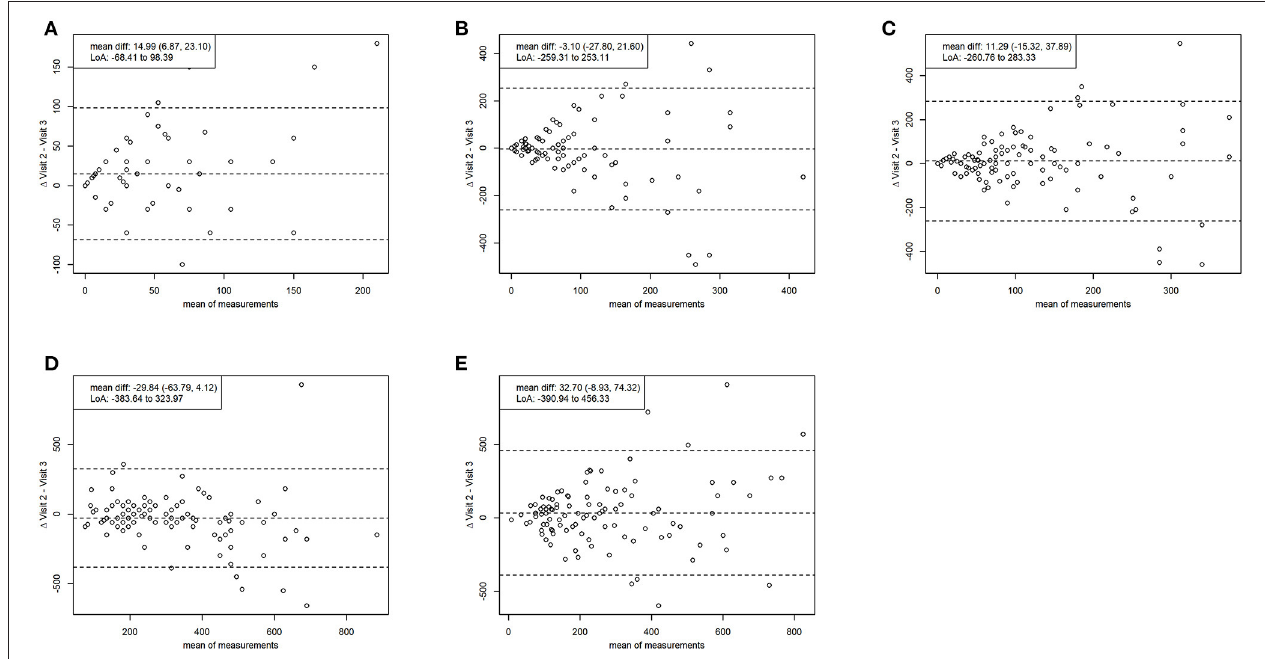
FIGURE 2 | Bland-altman plots reliability. Comparing average minutes intensive per day (A) , average minutes moderate per day (B) , average minutes moderate to vigorous per day (C) , average minutes sitting per day (D) , average minutes total physical activity (E) between the two measurement time points. Mean diff., mean difference with 95% confidence interval; LoA, limits of agreement (1.96